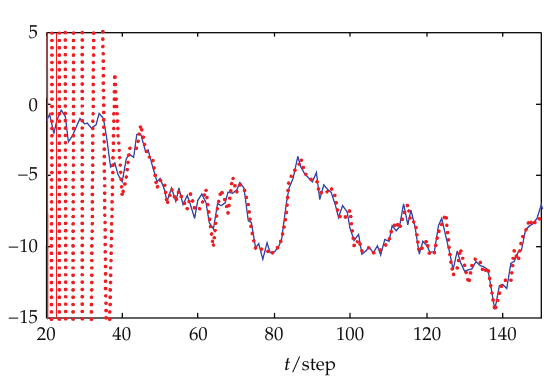
Figure 13: Speed x 2 and self-tuning WMF Kalman filter (cid:11) x